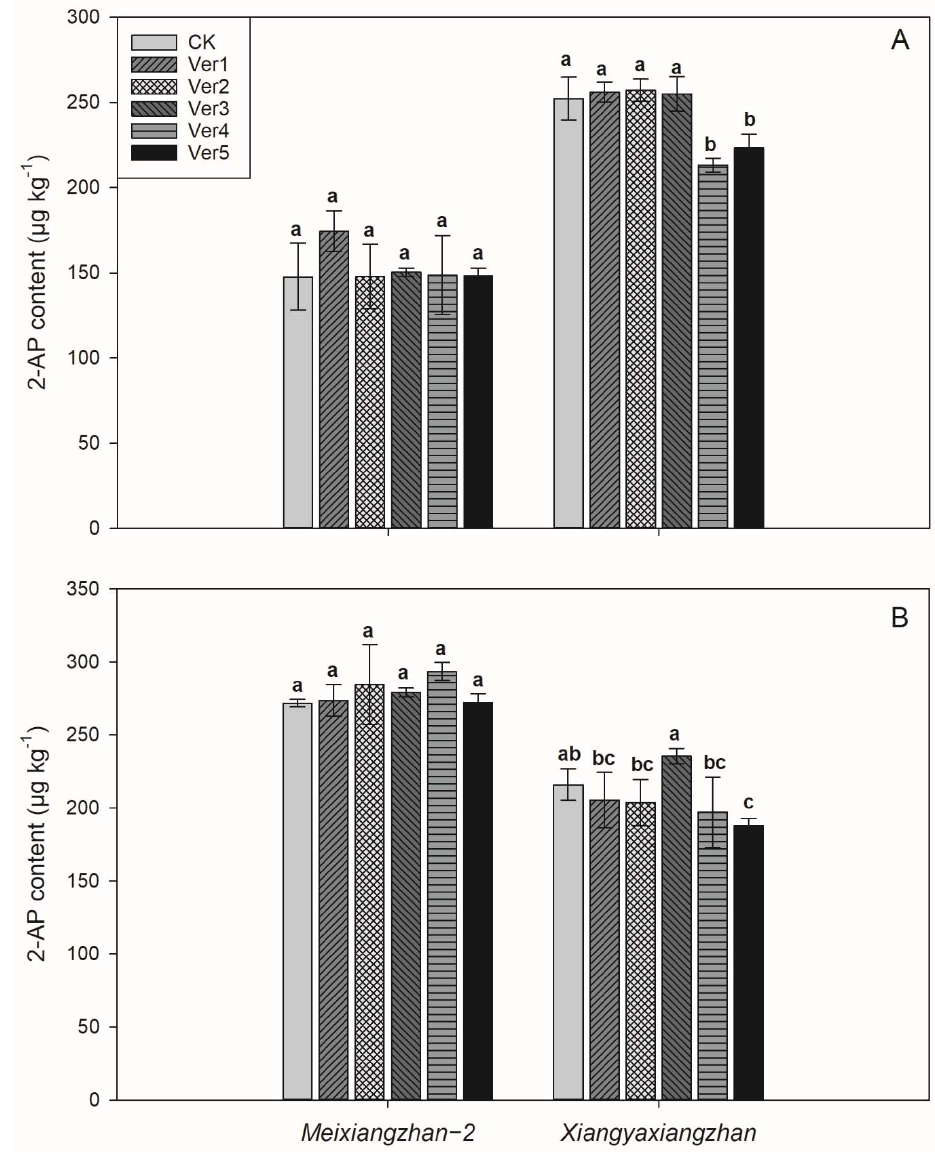
Figure 5. Effects of different vermicompost rates on grain 2-AP content of fragrant rice cultivars. ( A ) early lug; ( B ) late lug. Columns with same letters are not significantly different at p < 0.05.